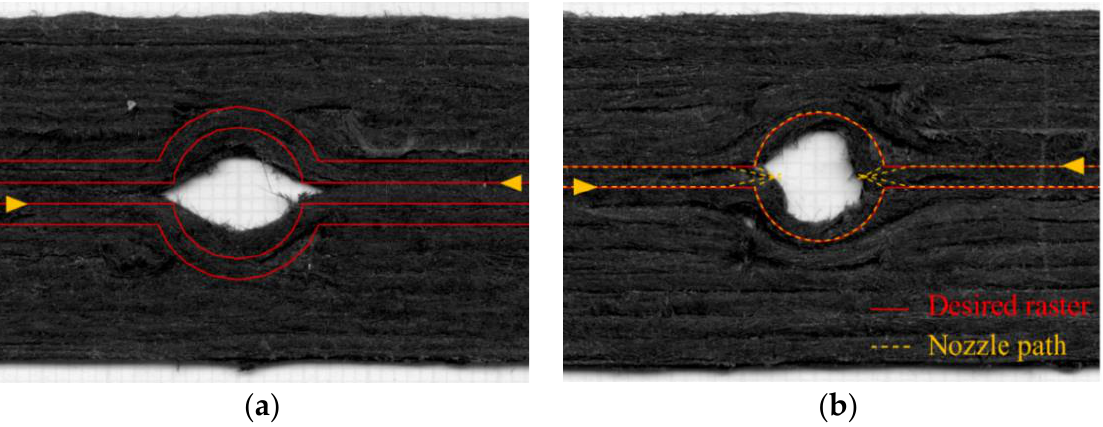
Figure 1. ( a ) Open hole printed part with normal curvilinear printing path; ( b ) open hole printed part with a manual printing path modification by moving the nozzle further inwards (the yellow arrows indicate the printing direction).